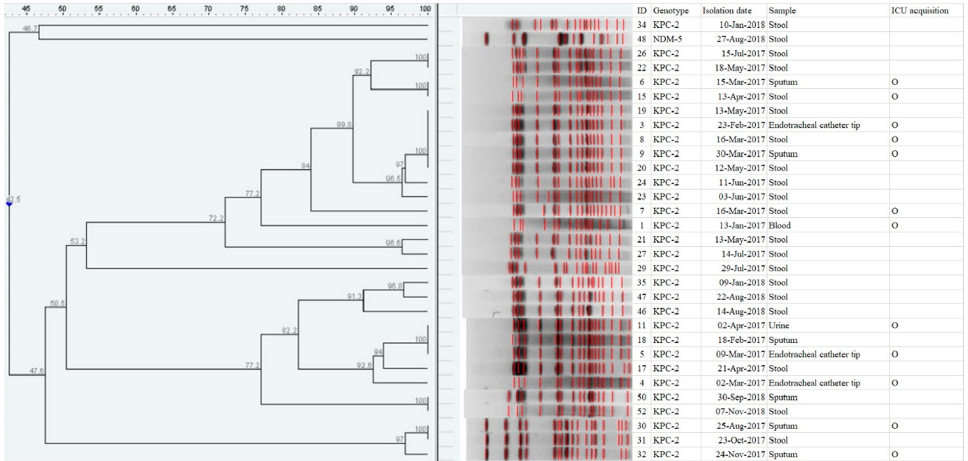
Figure 1. Dendrogram of XbaI -restricted DNA of carbapenemase-producing Klebsiella pneumoniae isolated from ICU-admitted patients (N = 31) (PFGE analysis was available in 31 of 32 isolates).